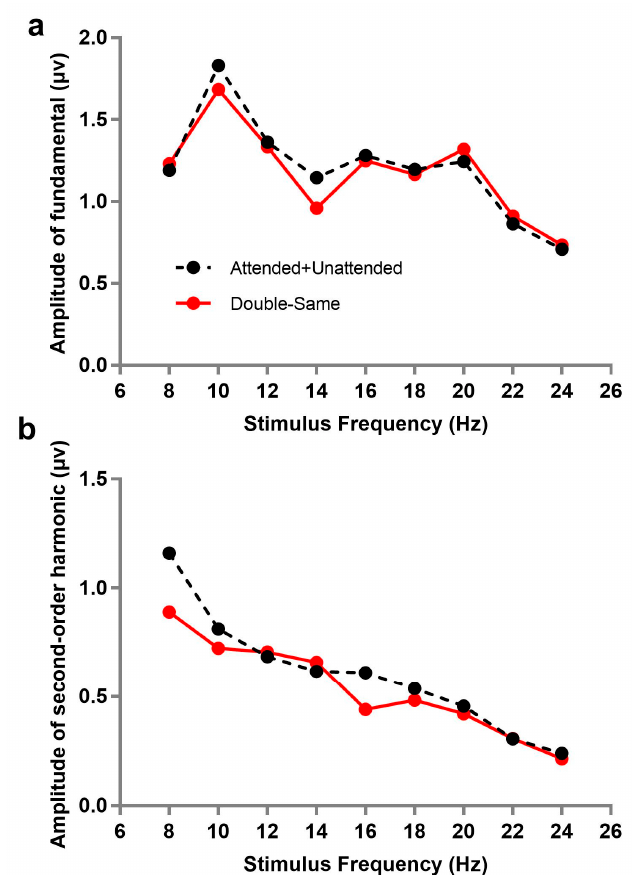
Figure 3. Amplitudes changed with stimulus frequency under different attention conditions: ( a ) amplitudes of fundamentals, ( b ) amplitudes of harmonics. Double-same (co-frequency) refers to two stimuli flashing simultaneously at same frequency; attended + unattended refers to the sum of responses of double-attended and double-unattended (double-attended corresponding to the attended stimulus when two flashing stimuli were presented simultaneously; while double-unattended, to the contrary, corresponds to the unattended stimulus in the same situation).